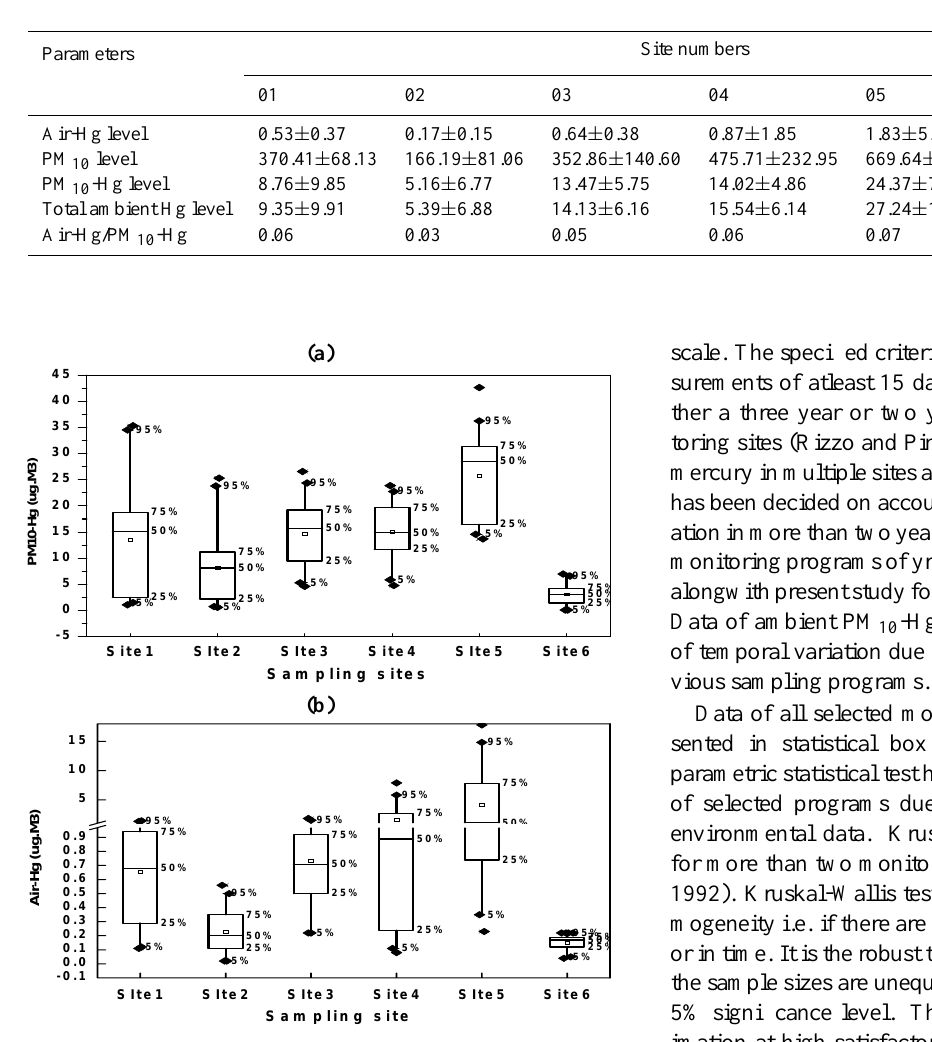
Table 2. Annual average (µgm − 3 ) and statistical data of ambient PM 10 and Hg concentration around an integrated steel plant, Bhilai during March 2005–February 2006.